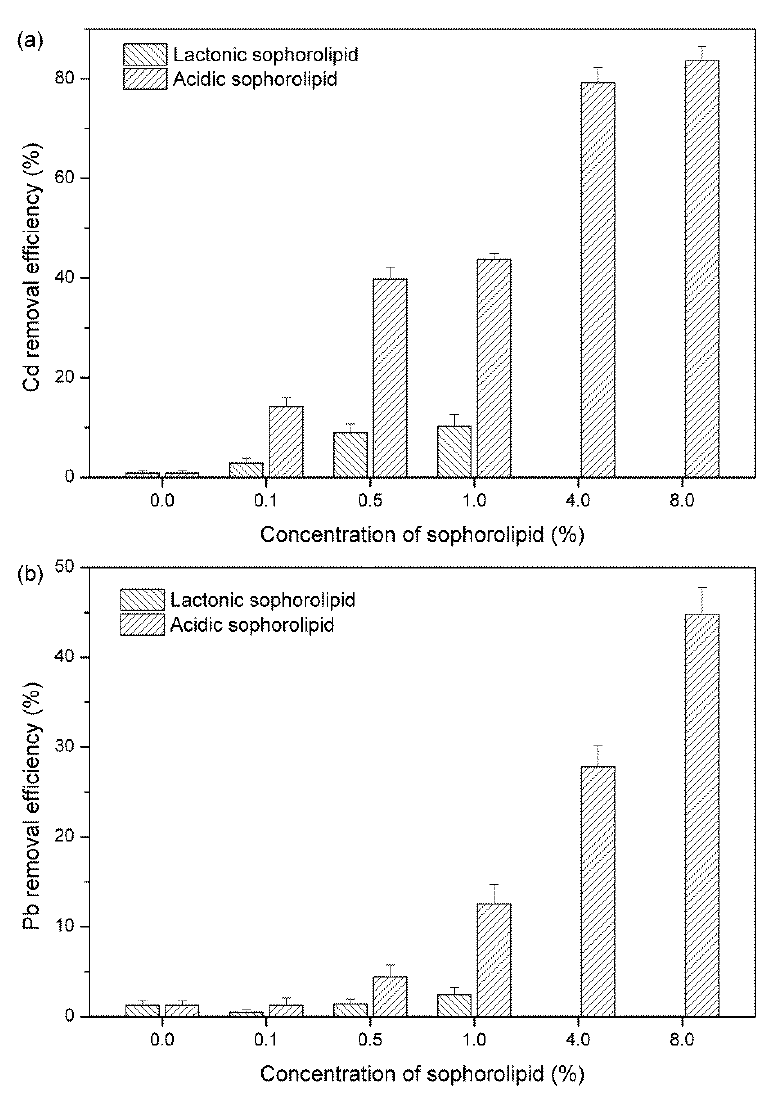
Figure 2. Removal efficiency of Cd ( a ) and Pb ( b ) by acidic and lactonic Figure 2 Removal efficiency of Cd ( a ) and Pb ( b ) by acidic and lactonic SLs.